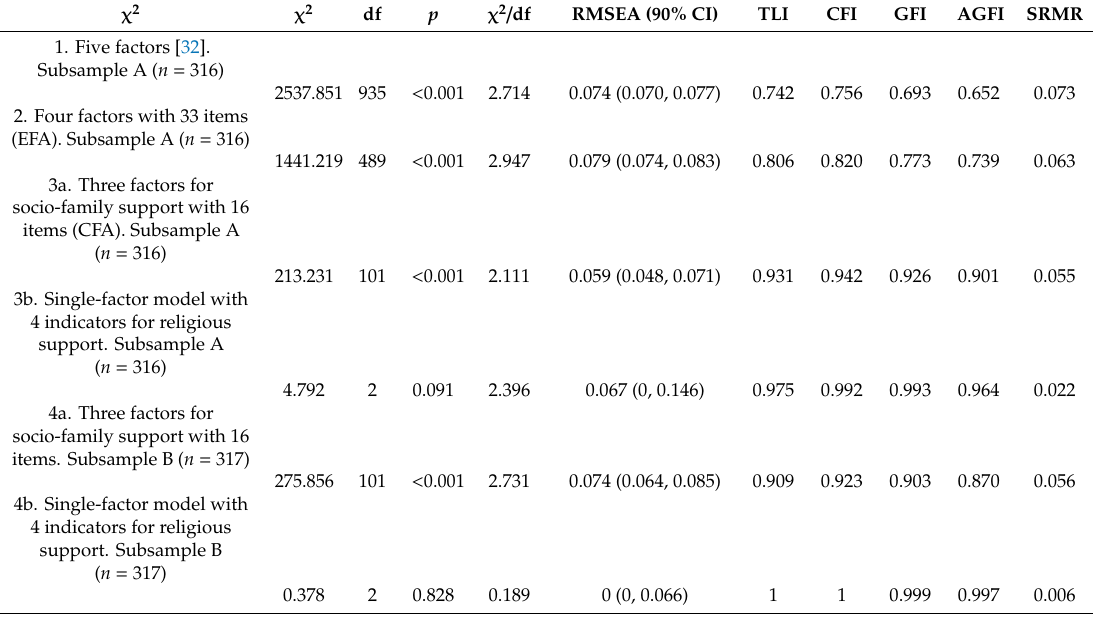
Table 2. Fit indices for 4 models for the Social Support Networks Scale (SSNS).